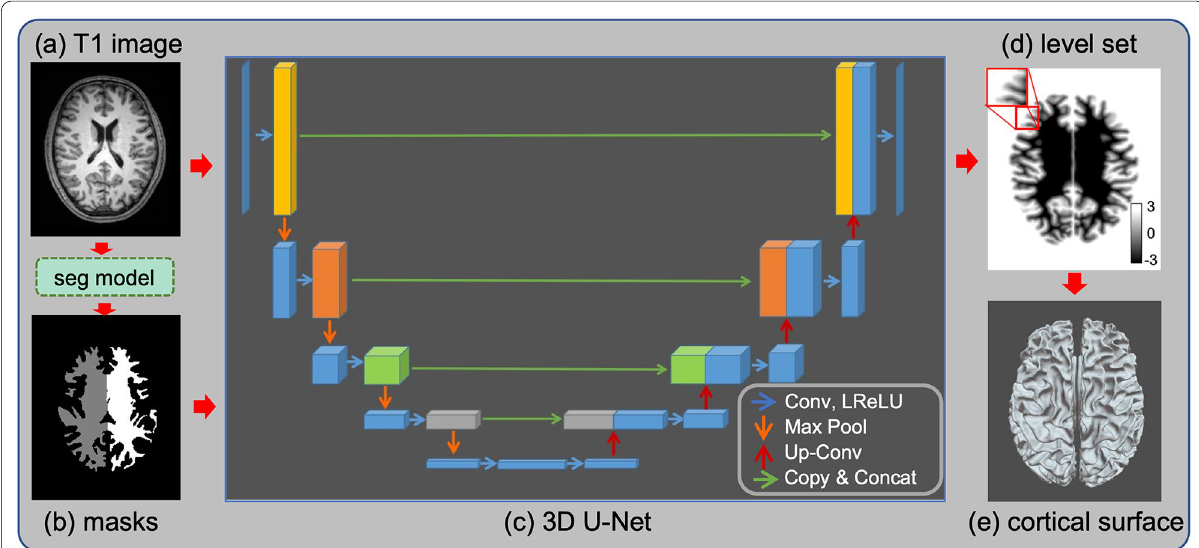
Fig. 1 Schematic of the fast cortical surface reconstruction (FastCSR) workflow. The FastCSR workflow can be summarized in four steps: a original T1w images are normalized and fed to a 3D U-Net for segmentation of white matter from gray matter. b After segmentation, hemispheric white matter masks are generated, distinguishing the two hemispheres in the T1w images. c The hemispheric masks and the original T1w images are fed to another 3D U-Net to predict the level set representation of the cortical surface. Level set is an implicit representation of the cortical surface. The U-shaped network architecture can be briefly described as follows: each blue arrow represents a 3 a leaky rectified linear unit (LReLU). Each orange downward arrow indicates a 2 upsampling followed by a convolution (Up-Conv). The long-range skip connections using the copy-and-concatenate (Copy & Concat) operation are indicated by green arrows. d The level set representations of the surfaces are generated by the deep learning model. The voxels whose level set value equals to zero delineate the boundary of the cortical surface. Negative voxels indicated by dark colors are below the surface and positive voxels indicated by light colors are above the surface. The red box shows the level set representation in the left frontal cortex magnified to better visualize the details in the surface boundary. e An explicit surface mesh is reconstructed from the level set representation through a fast topology-preserving isosurface extraction algorithm. The resulting surface is visualized using a dorsal